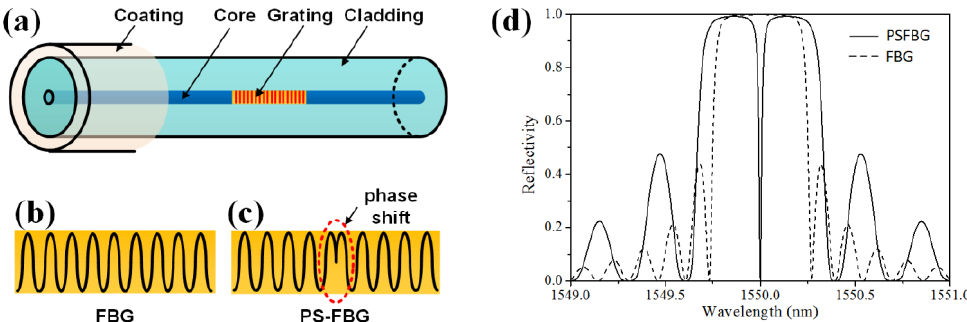
Figure 2. The introduction of fiber Bragg grating (FBG) and phase-shifted FBG (PSFBG). ( a ) The grating structure in an optical fiber; ( b ) the spatial index variation of an FBG; ( c ) the spatial index variation of a PSFBG; ( d ) the spectra of FBG and PSFBG.